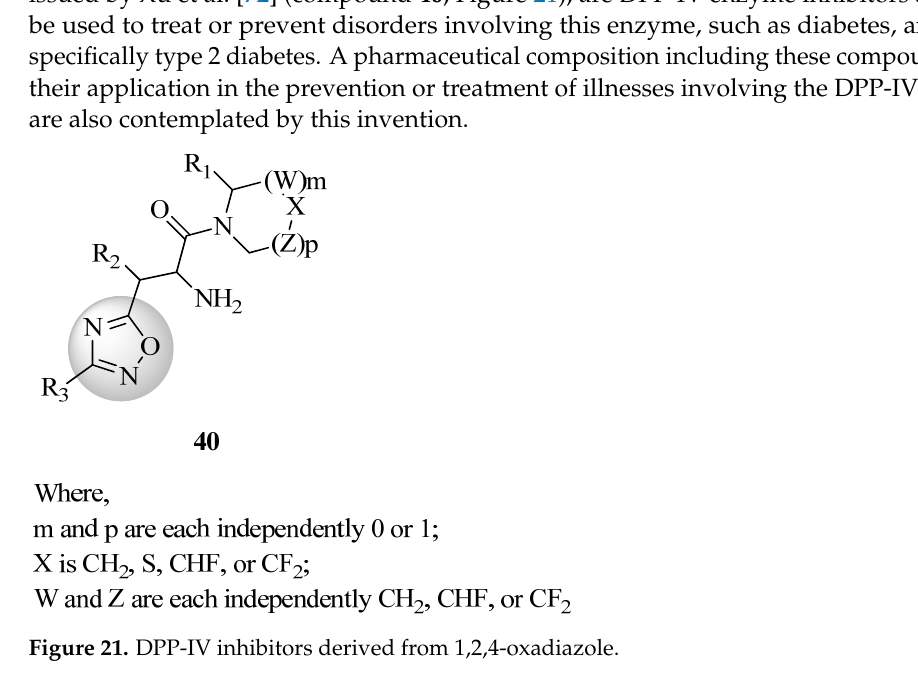
Figure 20. α -Glucosidase inhibitors based on oxadiazole hybrids.